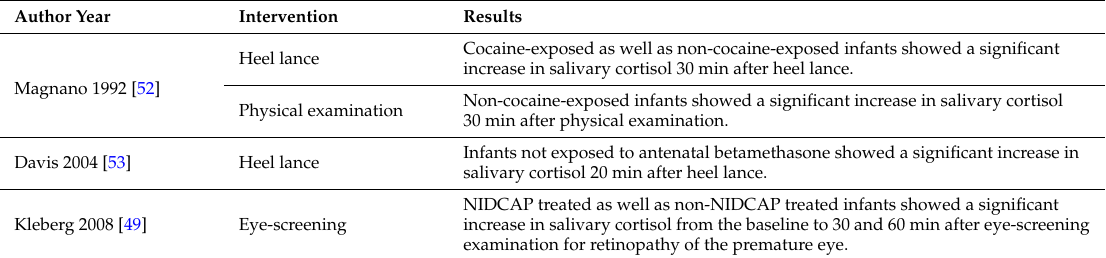
Table 2. Studies reporting an increase in salivary cortisol levels from the baseline with different interventions ( n =